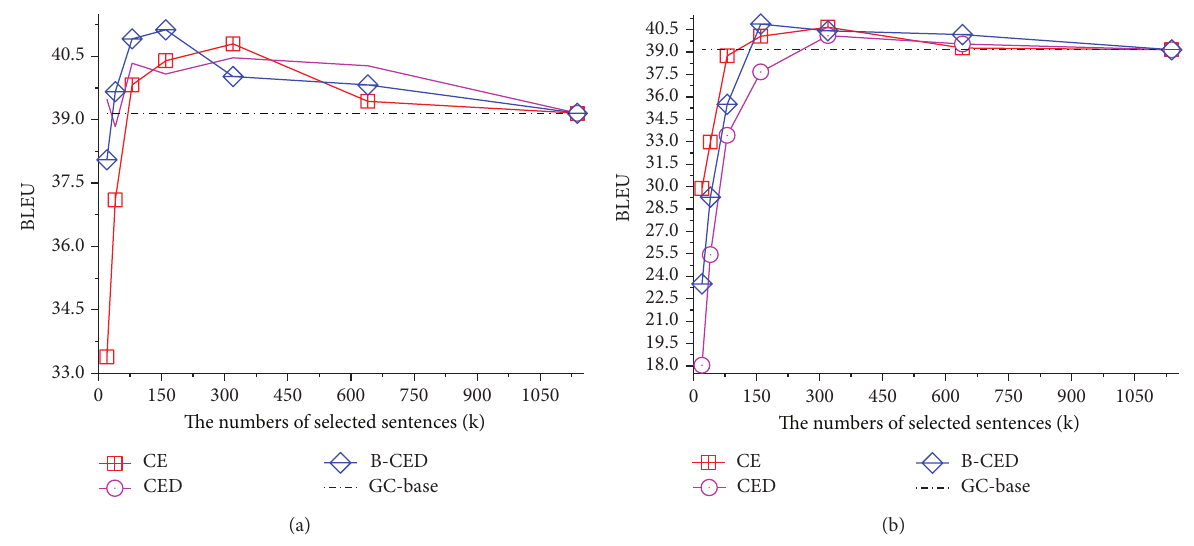
Figure 2: BLEU scores via perplexity-based data selection methods with dev. (a) and in-domain (b) strategies.